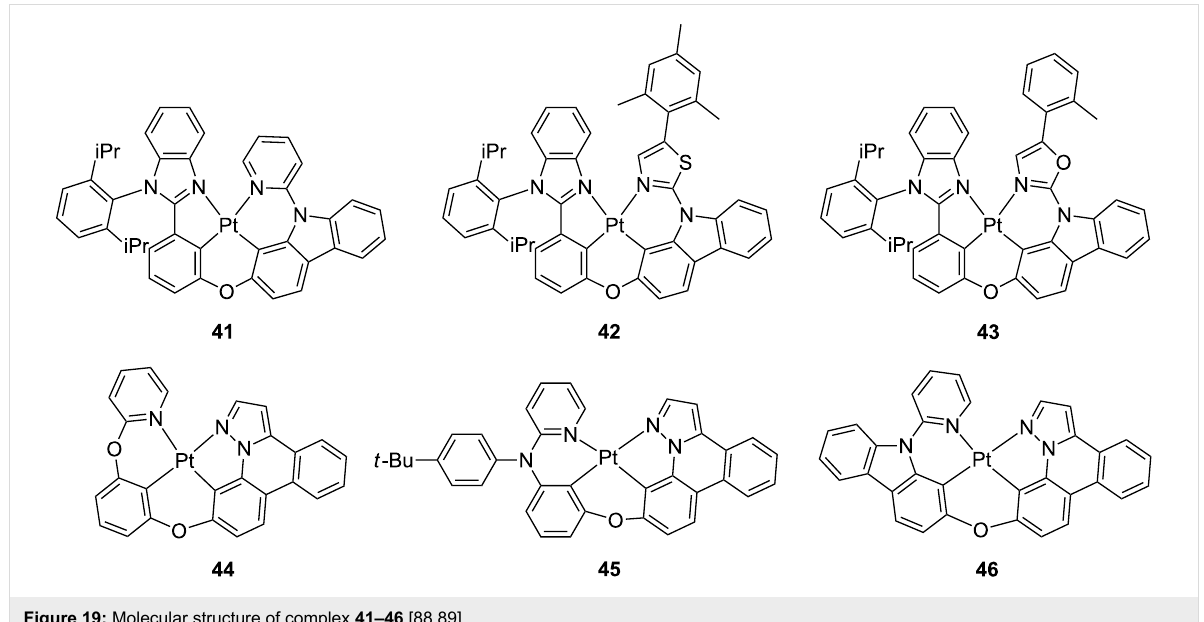
Figure 19: Molecular structure of complex 41–46 [88,89].